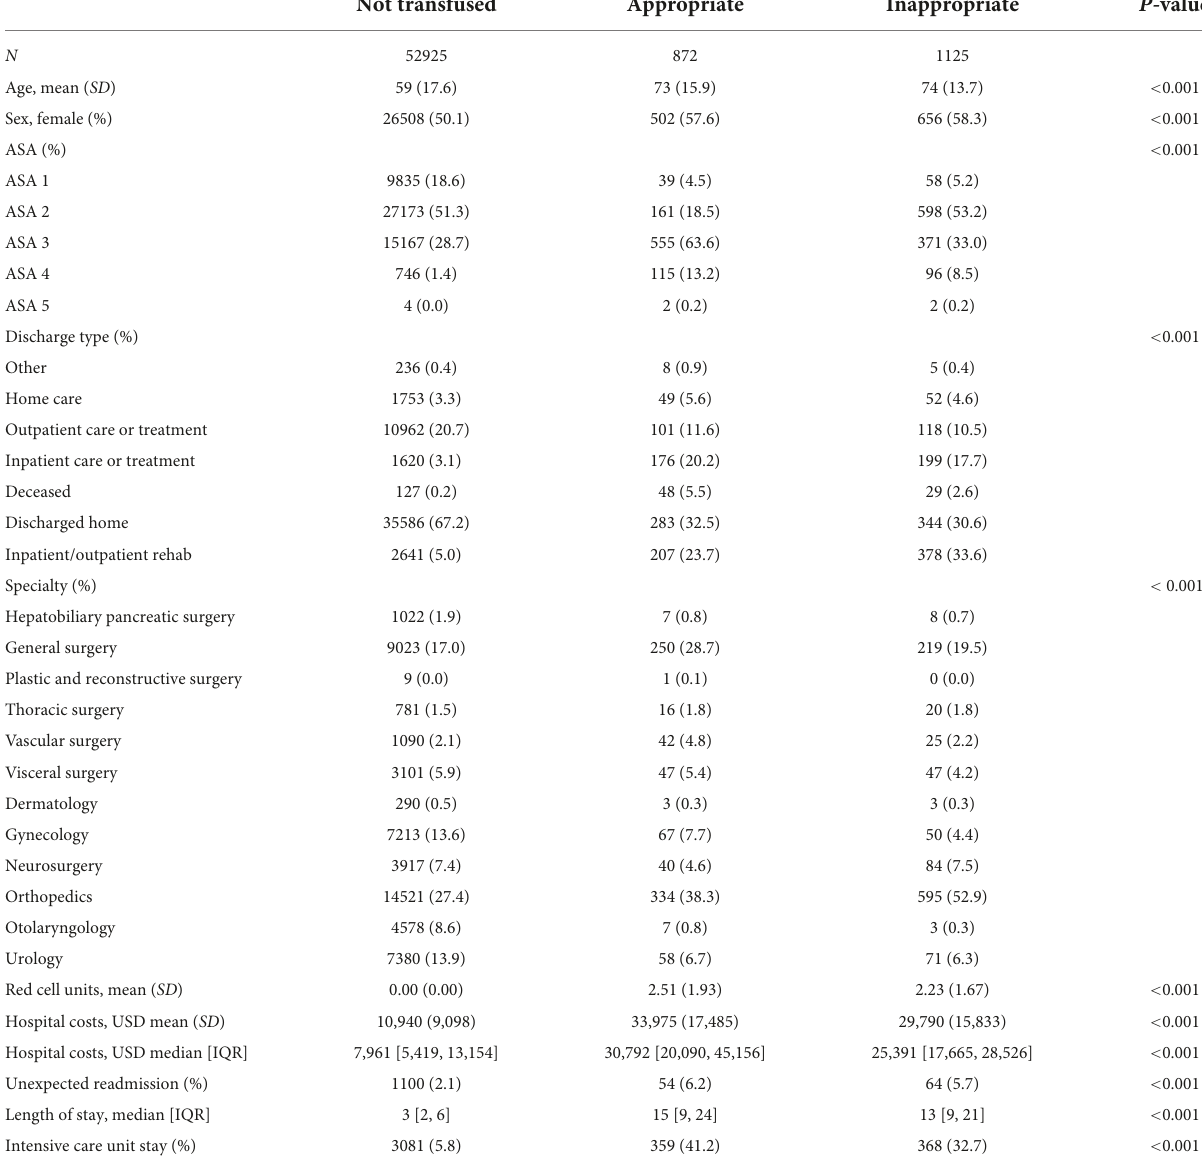
TABLE 1 Characteristics of inpatient admissions by red blood cell transfusion appropriateness. Not transfused